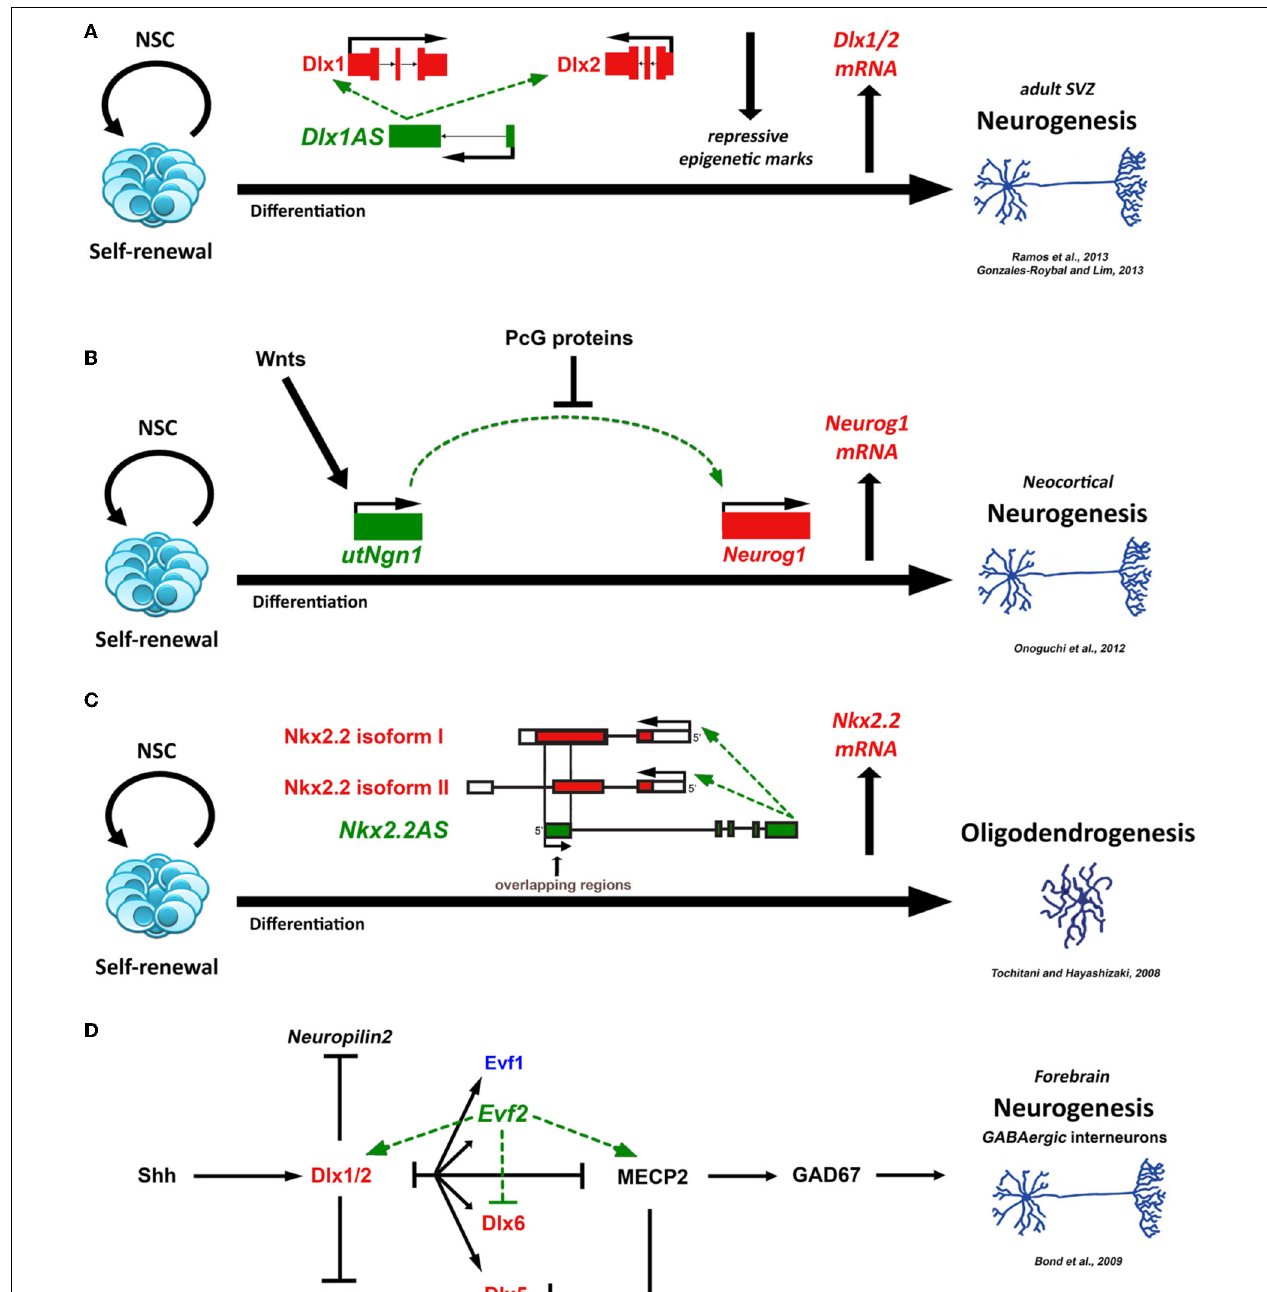
FIGURE 1 | Proposed schematic models for the role of different lncRNAs (green) in neural development. (A) LncRNA Dlx1AS consists of two exons that are spliced and the mature transcript is polyadenylated. During neuronal differentiation of adult SVZ NSCs, Dlx1AS is required for the induction of Dlx1 and Dlx2 (red) gene expression (Gonzales-Roybal and Lim, 2013; Ramos et al., 2013). (B) During neocortical neurogenesis, utNgn1 receive Wnt signals (i.e., Wnt3a) to induce the expression of Neurog1 (red). PcG protein-mediated mechanisms (i.e., Ring1B, H3K27me3, H3K4me3, H3K9/K14ac) lead to the suppression of utNgn1 (Onoguchi et al., 2012). (C) The overlapping regions of Nkx2.2AS and Nkx2.2 isoforms ( I and II -red)